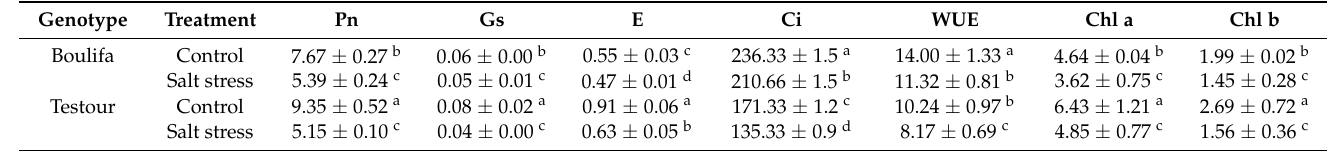
Table 2. Effect of salt stress on photosynthetic parameters in leaves of control and salt-stressed seedlings of Boulifa and Testour.